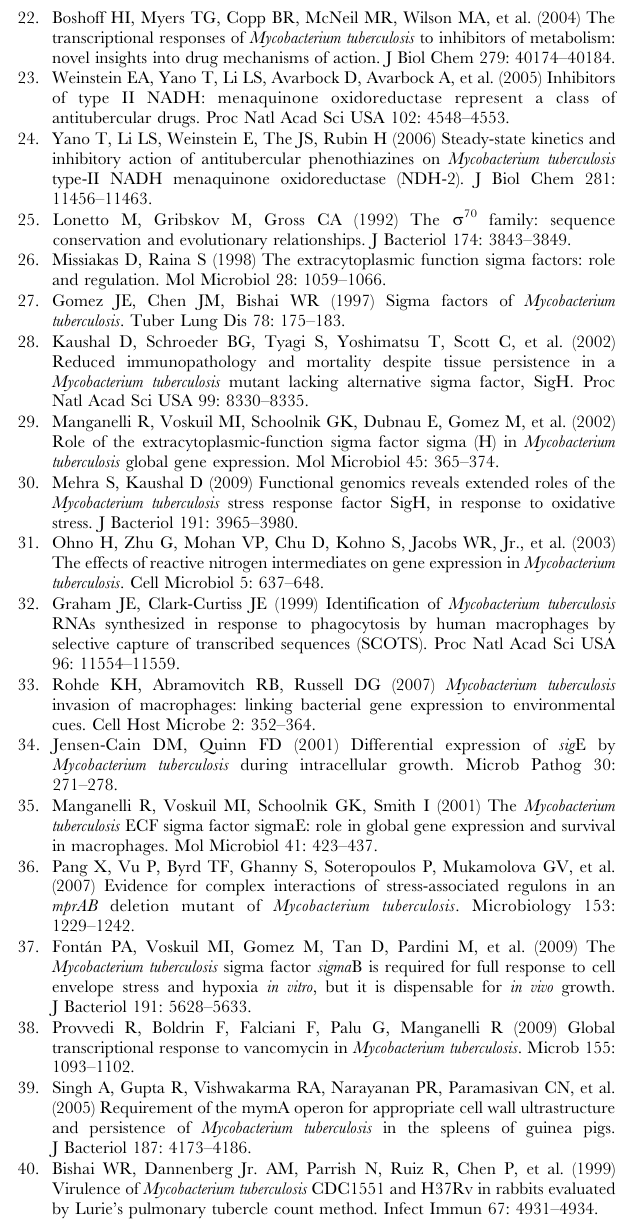
Figure S2 Venn diagrams. Venn diagrams show the degree of association between the transcriptional induction of Mtb genes in response to 1x (A) or 4x (B) THZ treatment at different time points. Numbers at the intersection of more than one oval indicate the number of genes overlapping between those time